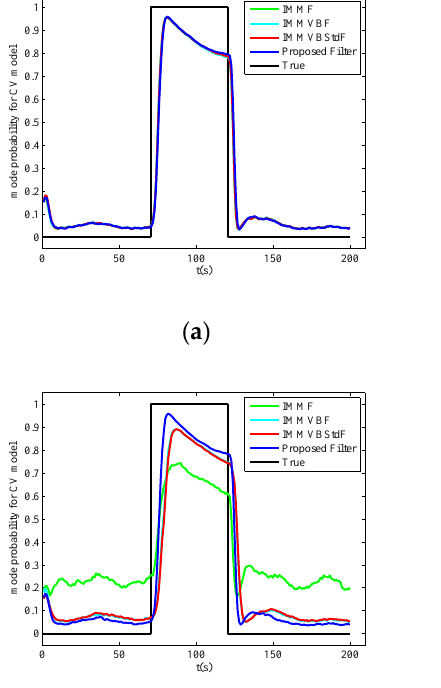
; ( b ) ˆ β 1 ; ( c ) ˆ α 2 ; ( d ) ˆ β 2 . k k k k